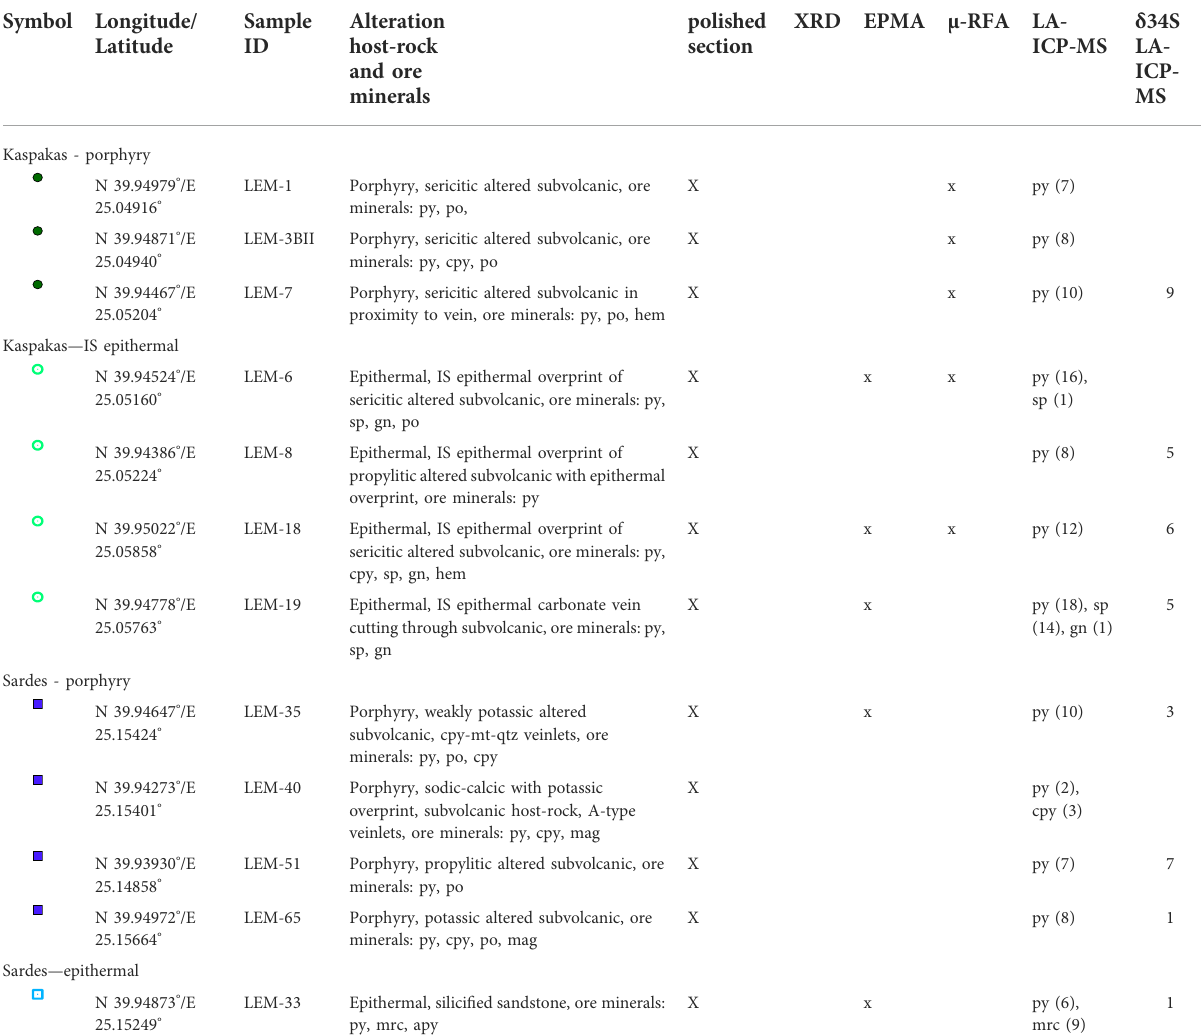
TABLE 3 Compilation of the investigated samples from Kaspakas and Sardes in this study with respect to sample, sampling site, alteration type, mineralogy and applied analytical techniques. Symbol Longitude/